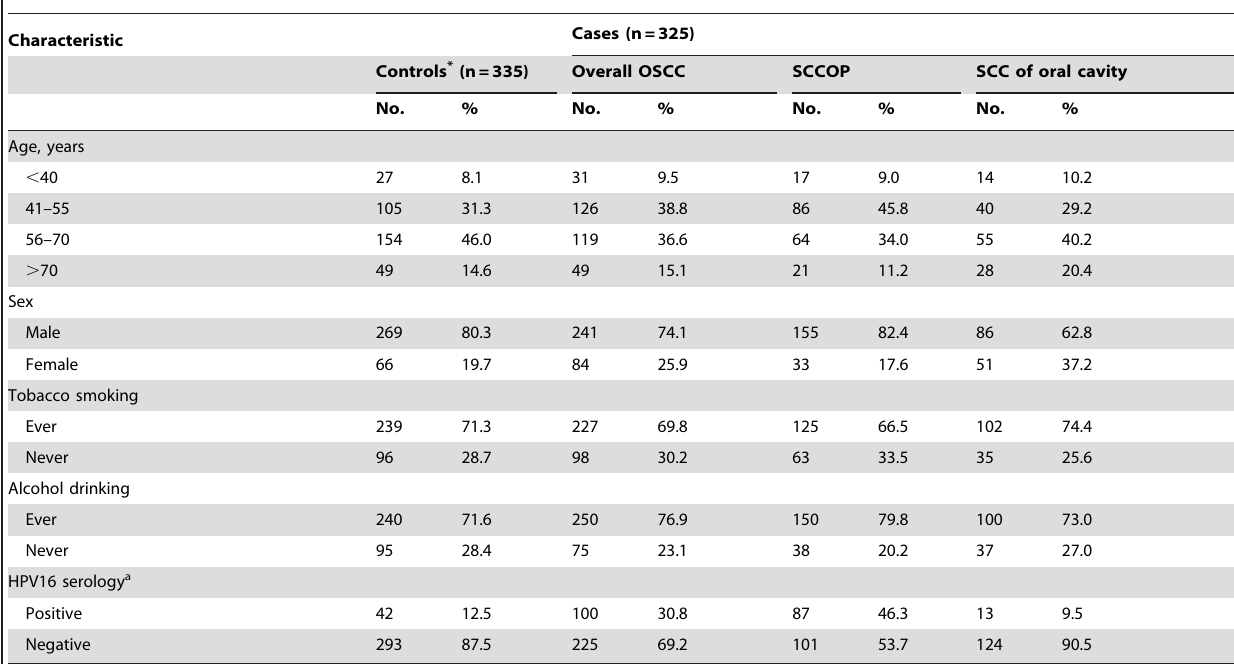
Table 2. Distribution of Demographic and Risk Factors in OSCC Patients and Controls.